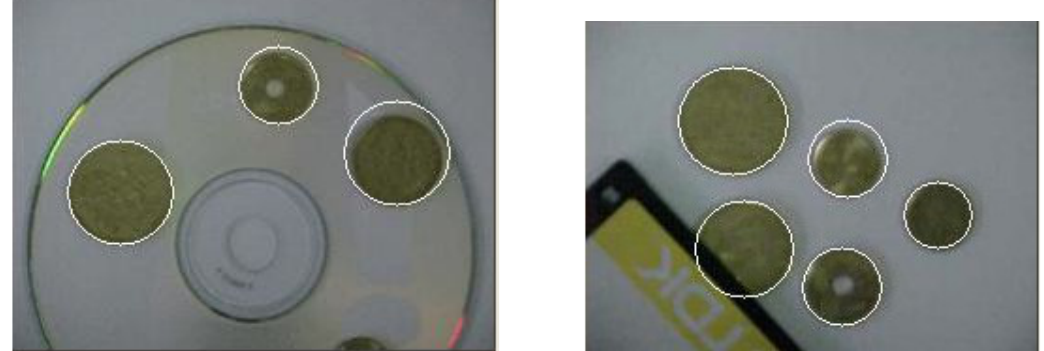
Figure 2. Two examples of the results of the lab assignment: countng coins. The white circumferences are the coins detected. Note that the CD is not detected as it has a diferent colour, and the inner circle of several coins is not detected